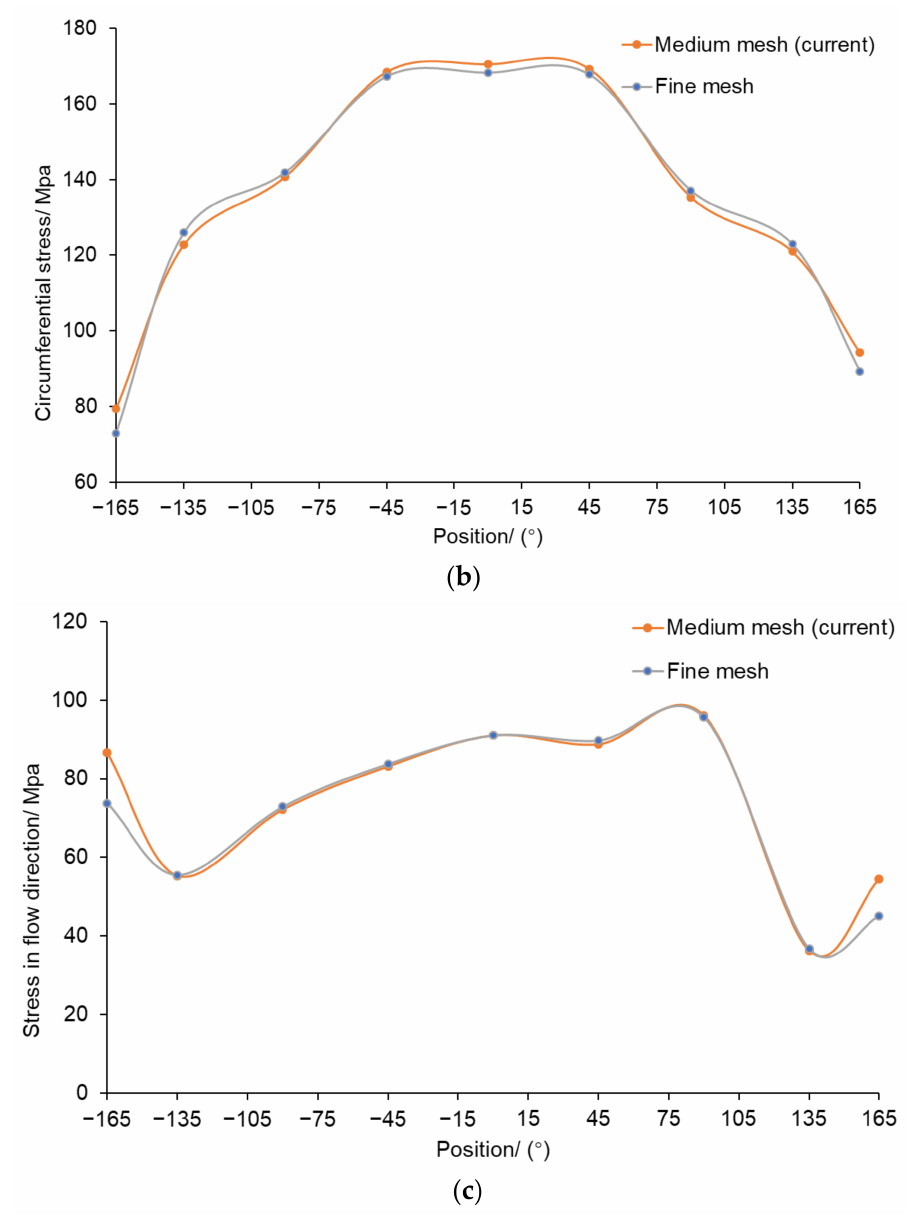
Figure 9. Mesh sensitivity analysis: ( a ) radial displacement; ( b ) circumferential stress; ( c ) stress in flow